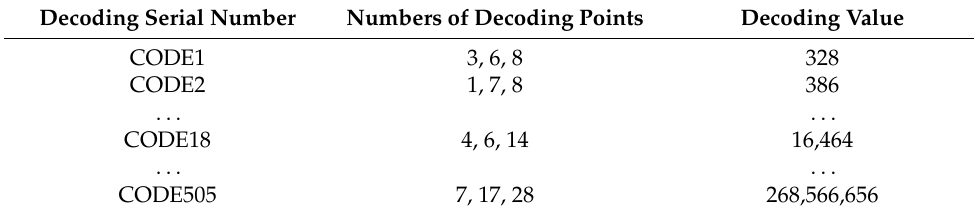
Table 2. The decoding library of